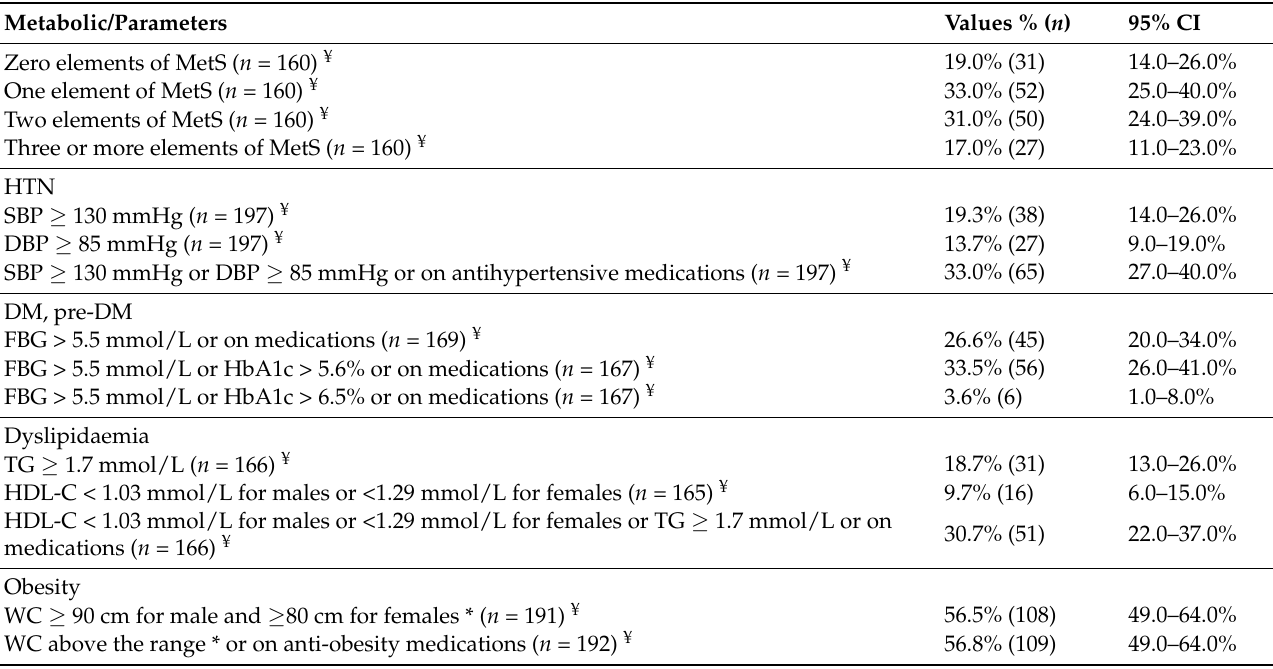
Table 4. Incidence of MetS and MetS elements 24-months